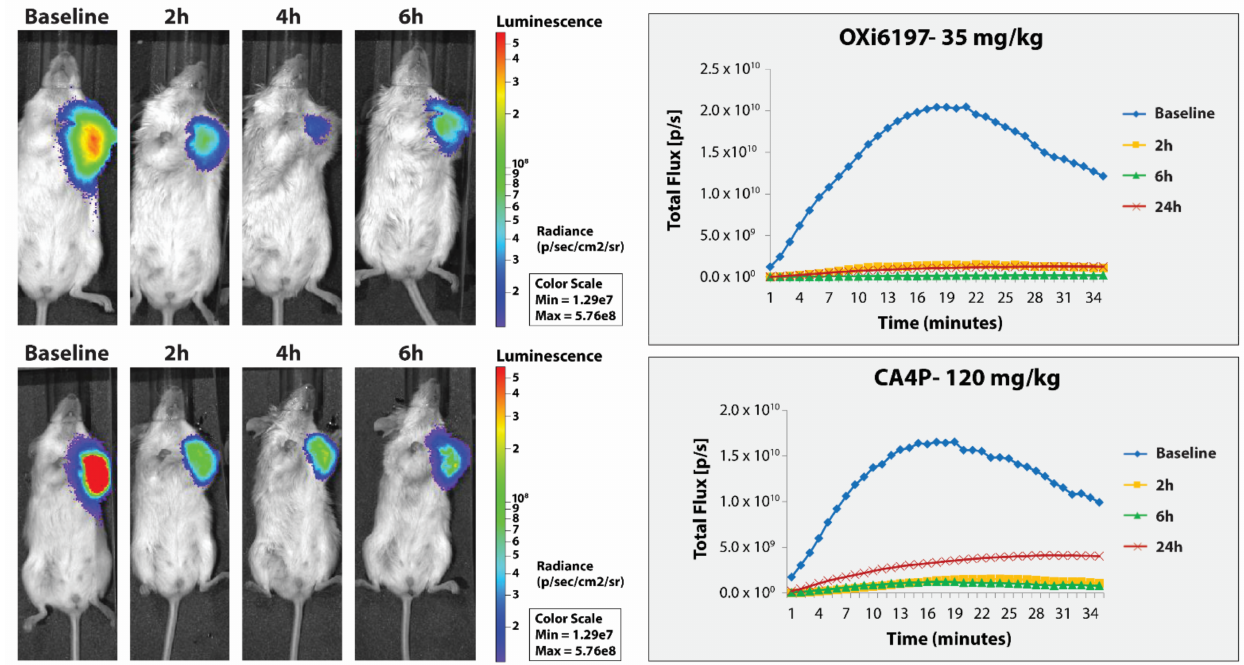
Figure 5. Comparison of vascular disrupting activity of OXi6197 and CA4P in orthotopic MDA-MB-231-luc tumors. ( Right ) BLI light emission curves obtained after administering